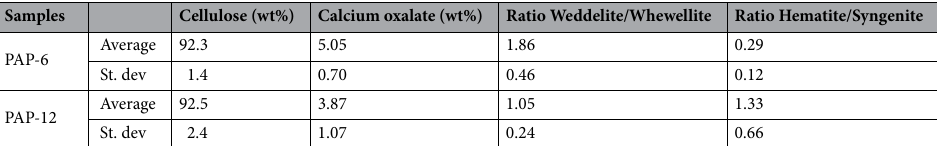
Table 1. Quantitative refinement results from the XRD data collected in the red solar disk region of PAP-6 and in the red region of the column decoration in PAP-12. Averages and standard deviations (St. dev.) are calculated from the refinement results of eight patterns in each case (see Tables S1, S2). The weight percent (wt%) in cellulose and in calcium oxalate were obtained after summing the contributions of the two cellulose phases and of weddellite and whewellite,